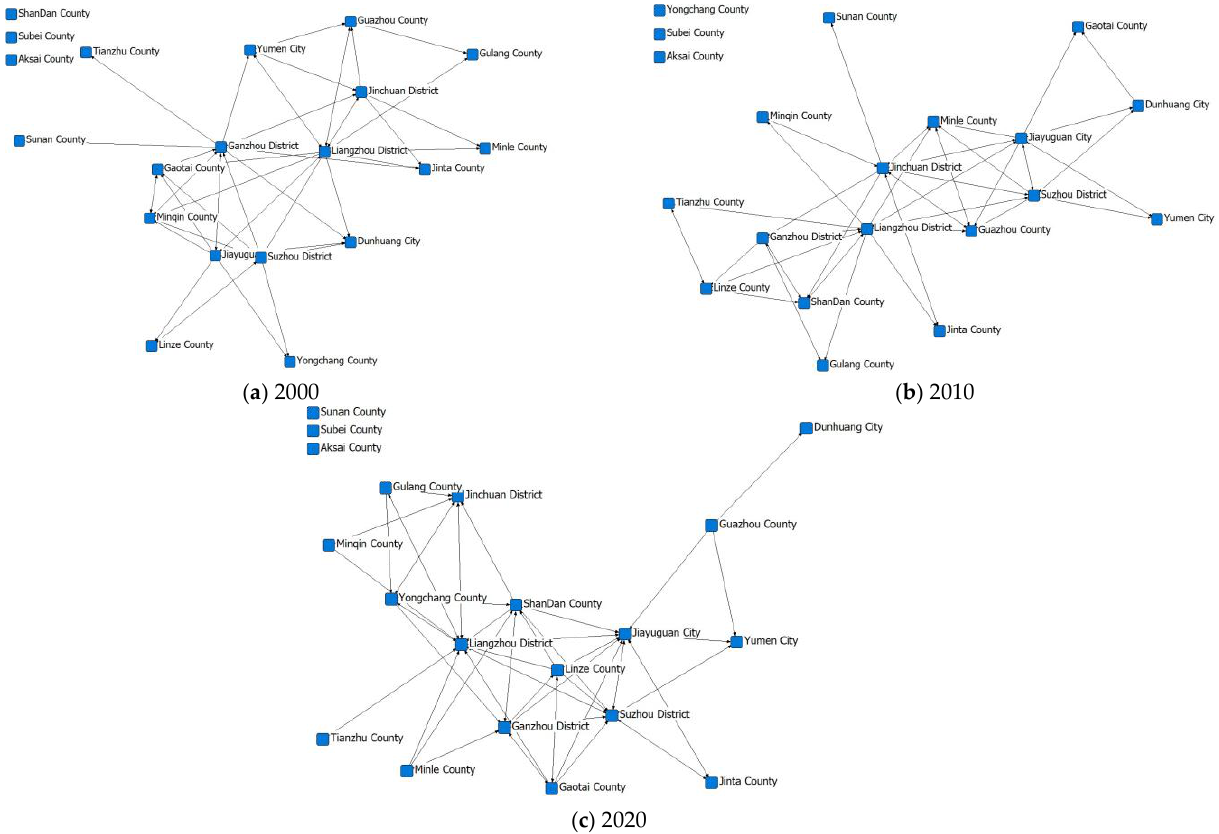
Figure 6. The economic spatial network structure of the Hexi Corridor urban agglomeration.